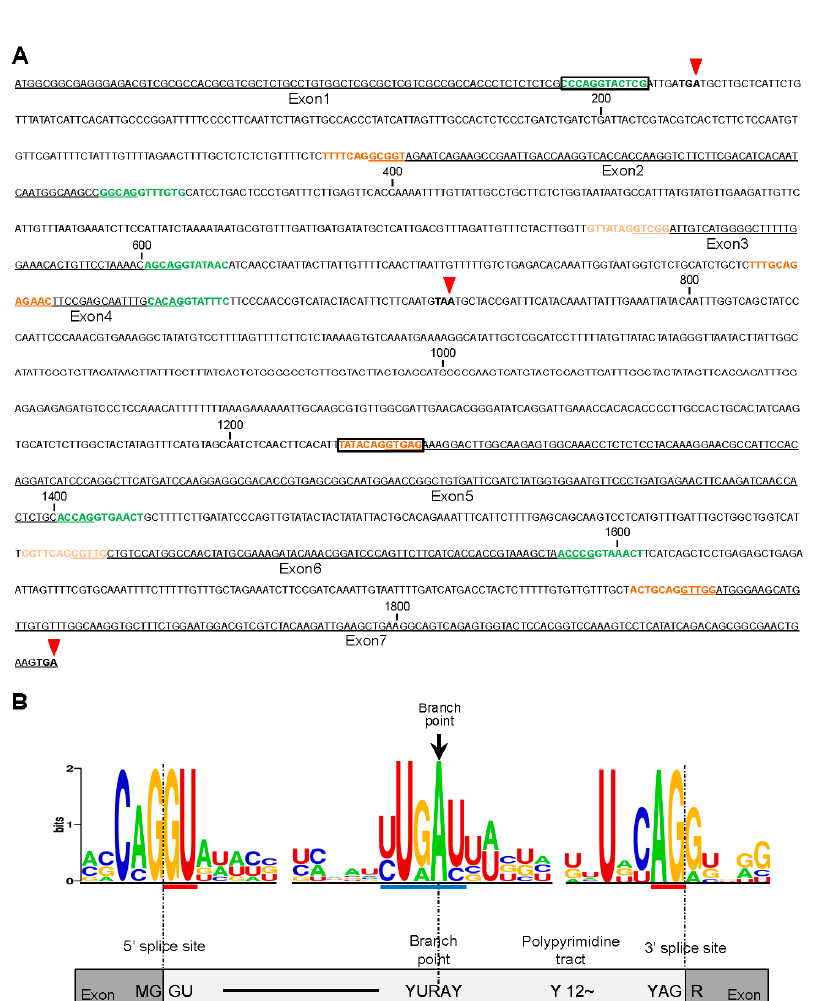
Figure 2. Nucleotide sequence annotation and splice site prediction in OsCYP19-4 DNA. ( A ) The positions of splice sites in OsCYP19-4. Exon sequences are underlined, and constitutive 5 ′ and 3 ′ splice sites (predicted by ASSP, NetGene2, and SplicePort tools) are indicated in green and orange, respectively. Boxes represent putative dual-aspect splice sites identified using the ASSP tool. PTCs are indicated by inverted red arrows. Numbers indicate base pairs; ( B ) Consensus sequences obtained from splice site prediction in OsCYP19-4 . Consensus sequences of 5 ′ and 3 ′ splice sites and branch points were derived from multiple sequence alignment of six introns in OsCYP19-4 and represented as annotated sequences using WebLogo. Blue and red bars indicate the boundaries of each functional sequence. The frequencies of A, C, G and T at each position are represented by the relative height of the corresponding letter. Schematic diagram below shows two exons and an intron. R = A or G; Y = C or T.